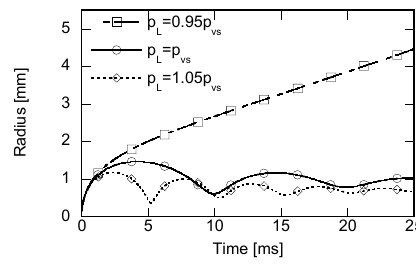
Fig. 10 Influence of decompression Δ p (= p L ∞ – p L 0 ) on the bubble motion with R 0 = 0.1 mm and T L 0 = 20 °C.